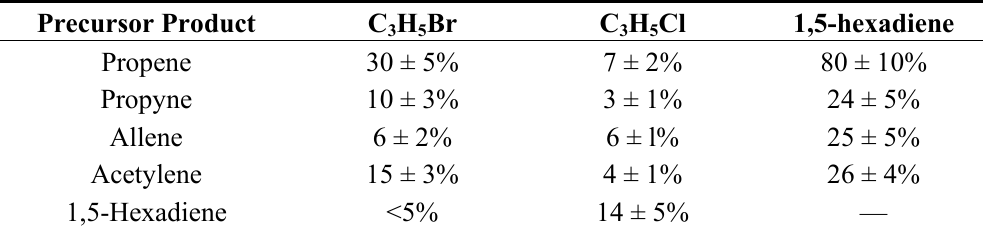
H Br) = 0.3 mbar; p(C 3 5